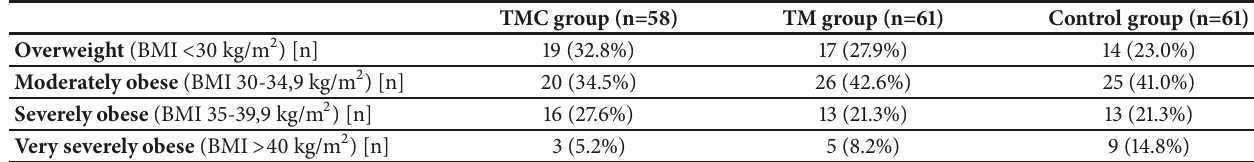
Table 2: Distribution of BMI categories between groups at baseline.